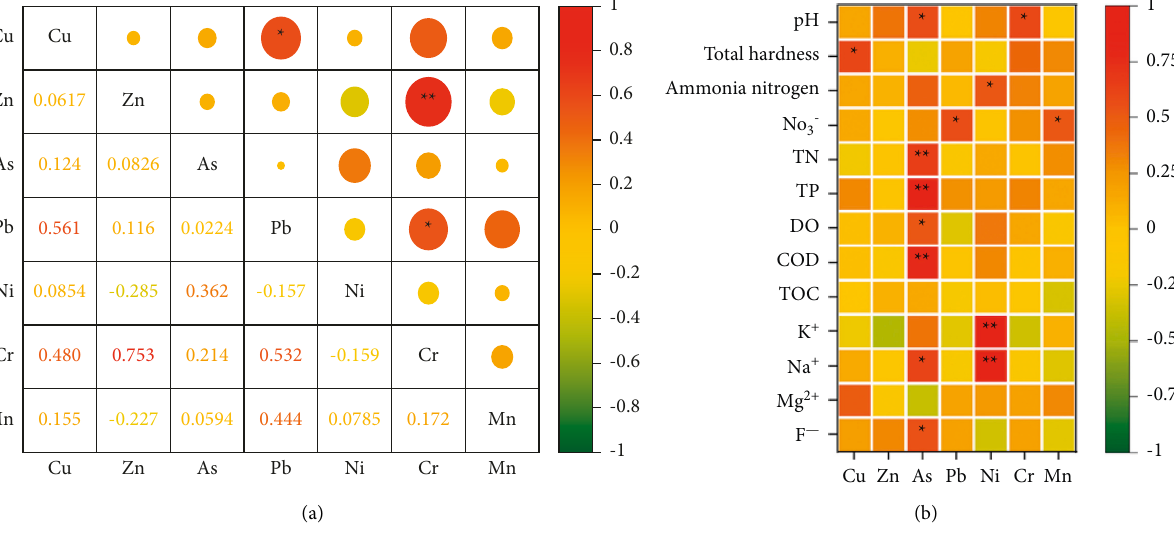
Figure 6: Heat map of correlation coefficient of heavy metal content in subsidence water bodies (a); heat map of correlation coefficients between heavy metals and other water quality parameters in subsidence water bodies (b).